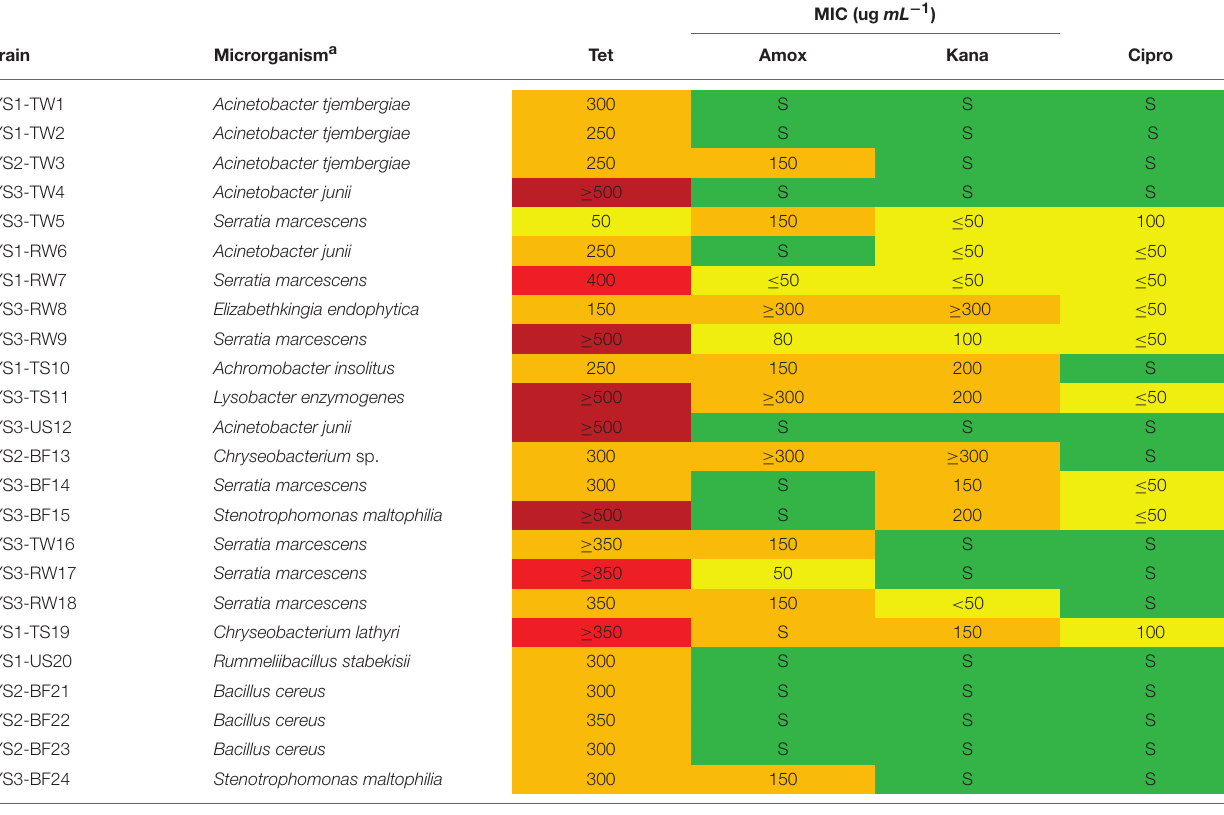
a The names refer to the closest relative species identified by 16SrDNA sequencing ( Table 2 ). Tet, Tetracycline; Amox, Amoxicillin; Kana, Kanamycin; Cipro, Ciprofloxacin. ≤ = microorganism growth was inhibited by the lowest concentration of the antibiotic tested. ≥ = microorganism growth was not inhibited by the higher concentration of antibiotic